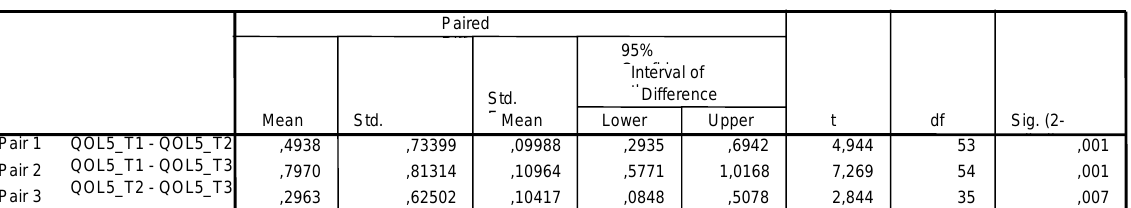
Quality of Life as Measured with the Validated Questionnaire QOL5 Significantly Improved with Clinical Holistic Medicine Paired Samples